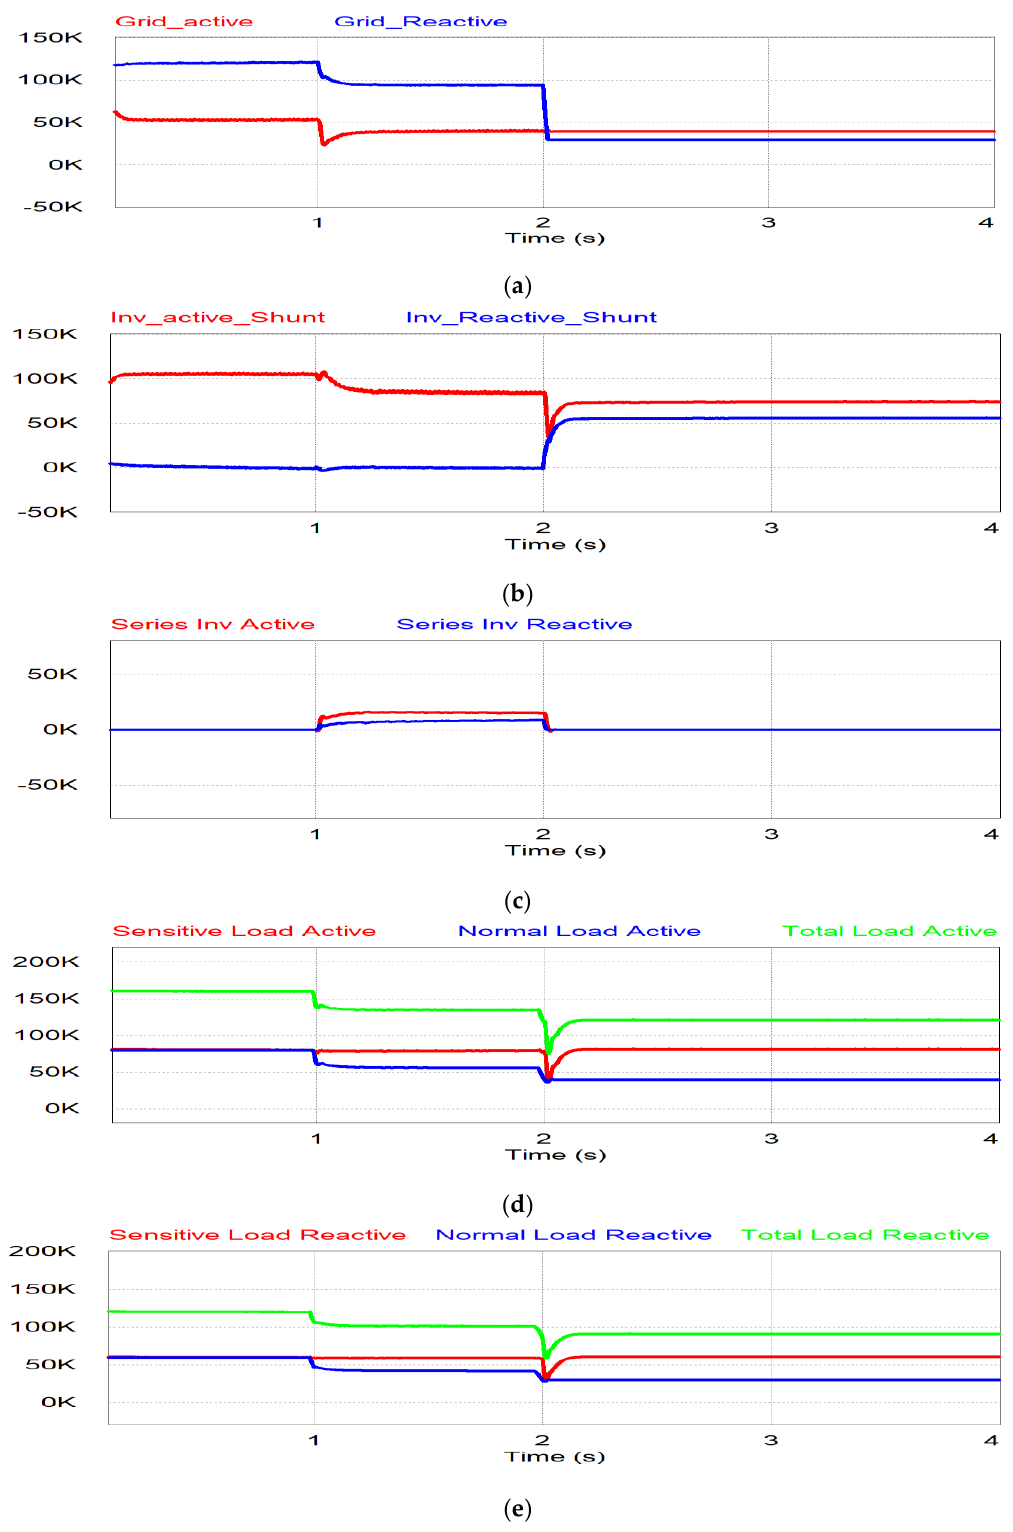
Figure 14. Simulation results of undervoltage: ( a ) Grid power; ( b ) shunt inverter power; ( c ) series inverter power; ( d ) active power for sensitive, normal and total load; ( e ) reactive power for sensitive, normal and total load.